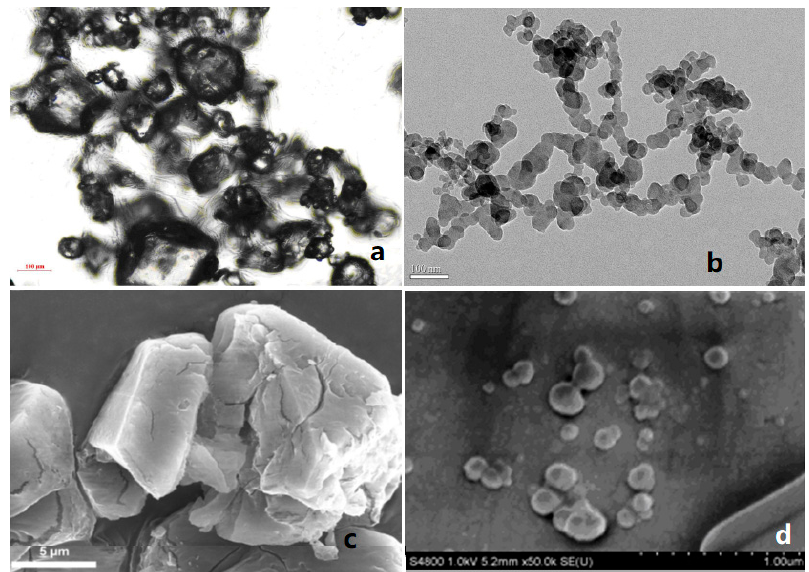
Figure 1. SEM images of micro-sized nitramines and corresponding nano-sized nitramines. ( a ) Raw RDX; ( b ) nRDX; ( c ) Raw HMX; ( d ) nHMX. Reproduced from [19–21], with permission from Explosive Materials (Bao Po Qi Cai), 2013; Propellants Explos. Pyrotech., 2014; Explosive Materials (Bao Po Qi Cai), 2014, respectively.